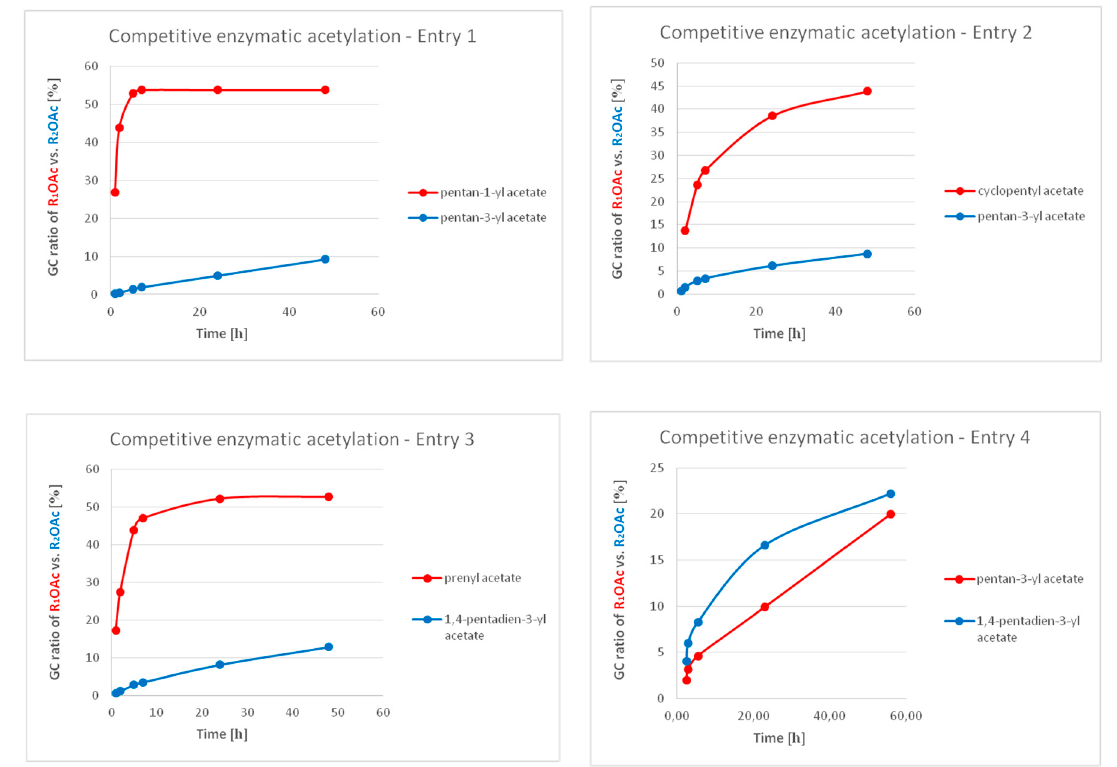
Figure 1. Time-dependent evolution of the ratio between forming acetates during competitive experiments (cf. Scheme 3, cf. Tables S3–S6 in the Supporting Information).